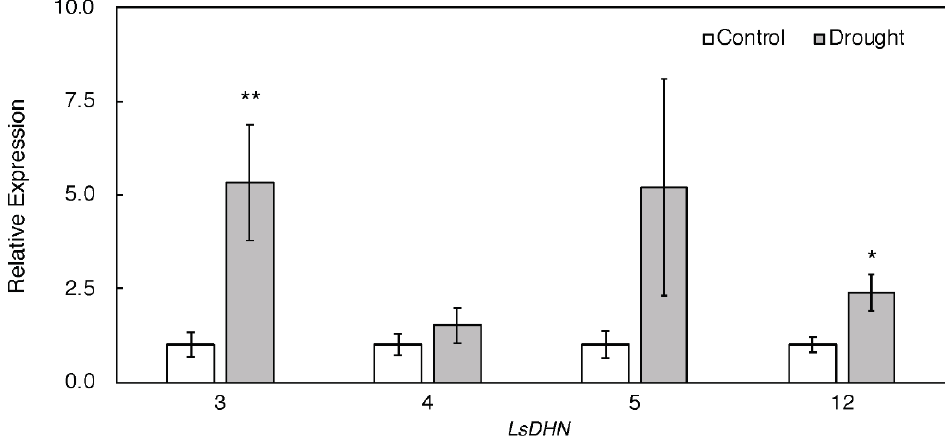
Figure 5. Verification of gene transcript levels of DHN s in lettuce using real-time PCR. RNA was extracted from non-stressed (white bars) or drought-stressed harvests (gray bars). The relative transcript levels of LsDHN3 , LsDHN4 , LsDHN5 , and LsDHN12 were normalized against that of the actin gene. Control levels were adjusted to 1.0. Vertical bars represent the standard errors of three biological and four technical replicates. The asterisk indicates a significant difference when compared with the control (** p < 0.01, * p < 0.05; Student’s t -test).